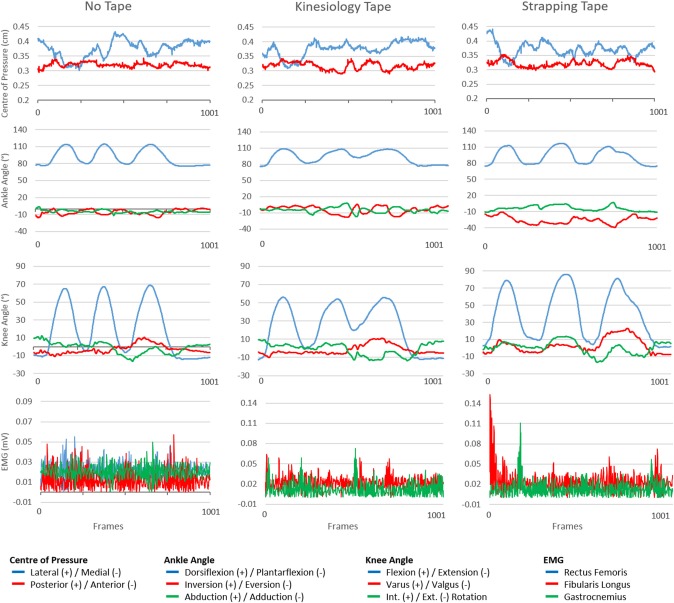
Graphing of center of pressure, ankle angle, knee angle, and electromyography values across three taping variables (no tape, kinesiology tape, strapping tape) over a normalized 1001 frame time series.